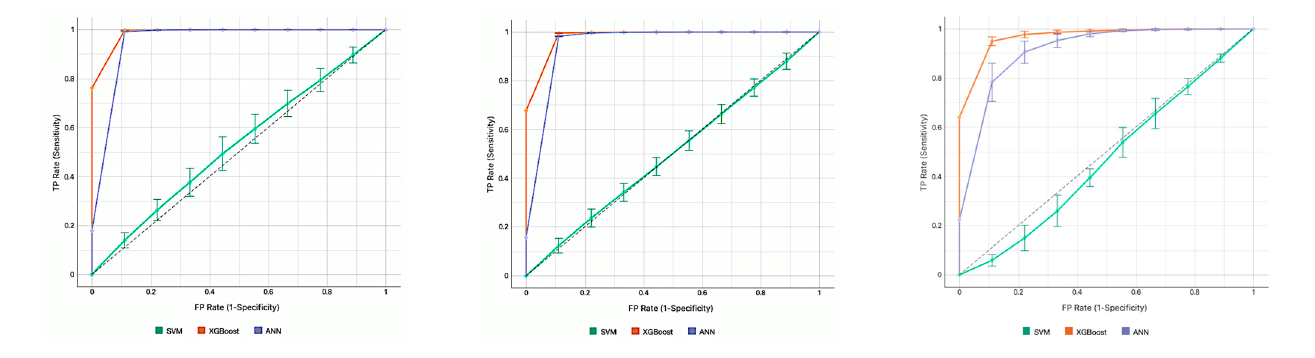
Table 14. ROC analysis of all the models based on the datasets balanced using hybrid sampling techniques.